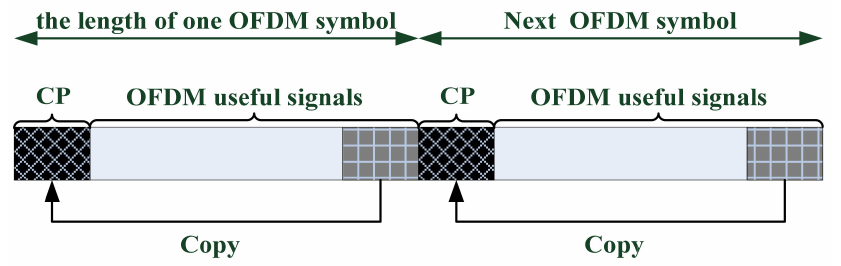
Figure 6. LTE signal OFDM modulation schematic diagram.